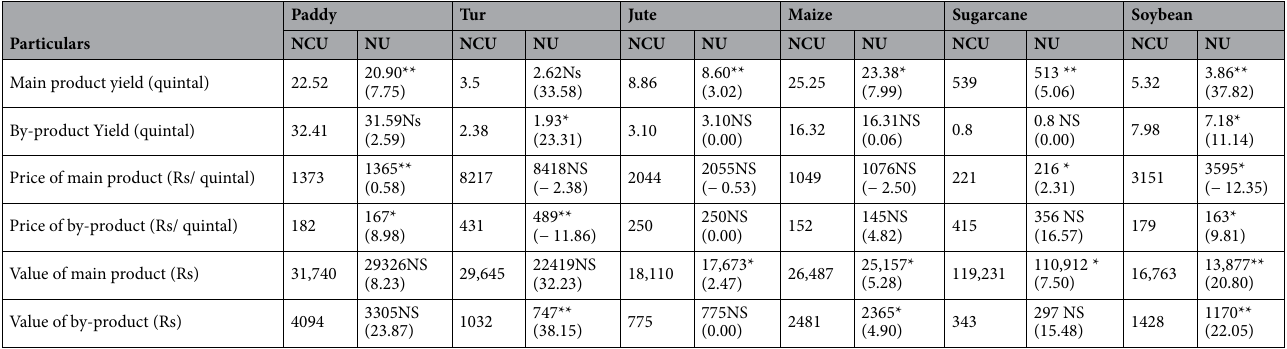
Table 6. Impact of NCU on production and marketing of reference crops. (Quintals/acre). Source: Authors’ estimates using field survey data. ** & * denotes significance level at 1 and 5%, respectively. Figures in parentheses indicate percentage